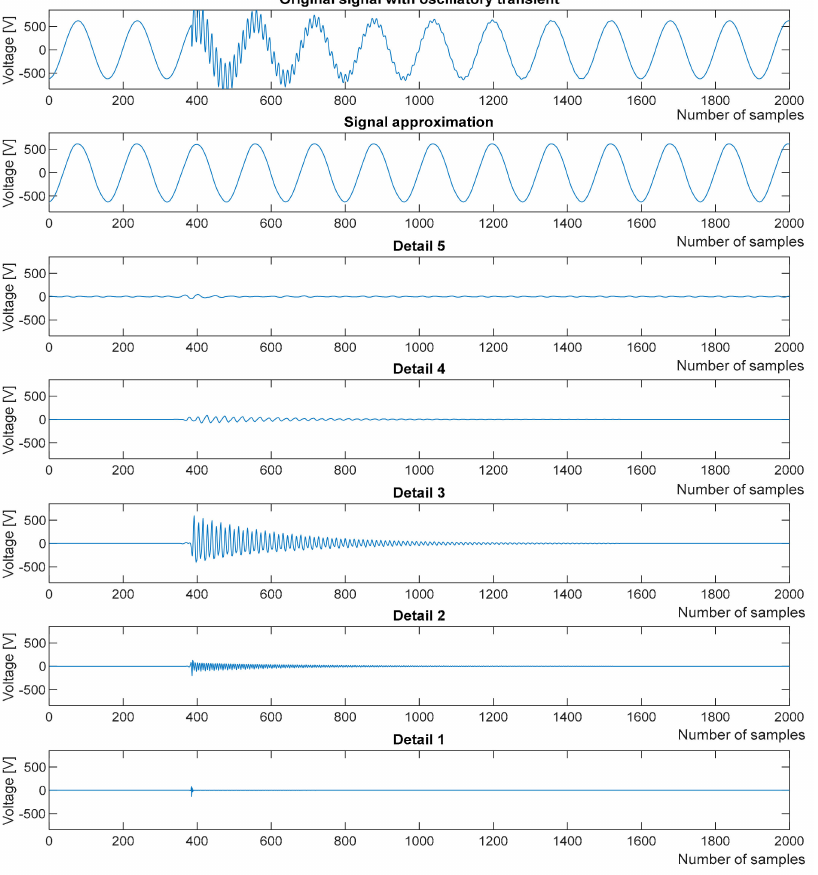
Figure 4. DWT decomposition on the example of oscillatory